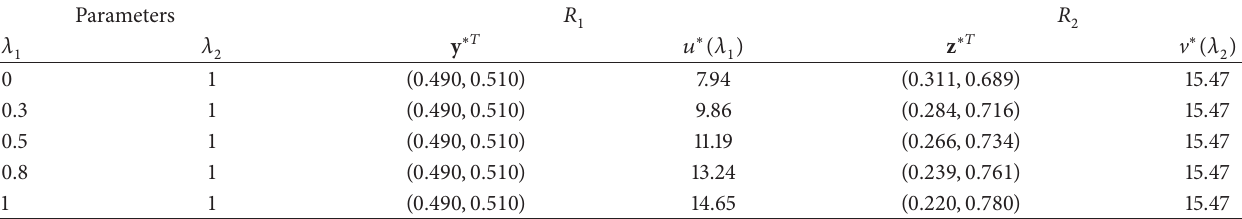
Table 6: Satisfying Nash equilibrium values and corresponding strategies of commerce